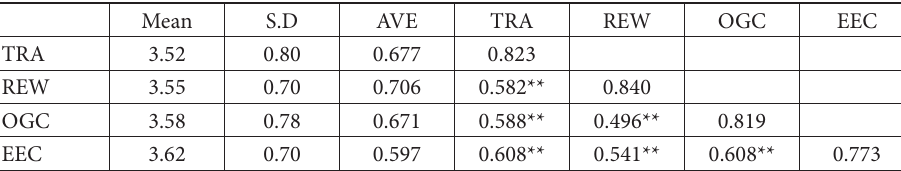
Table 3. Correlations, AVE, and Discriminant validity of